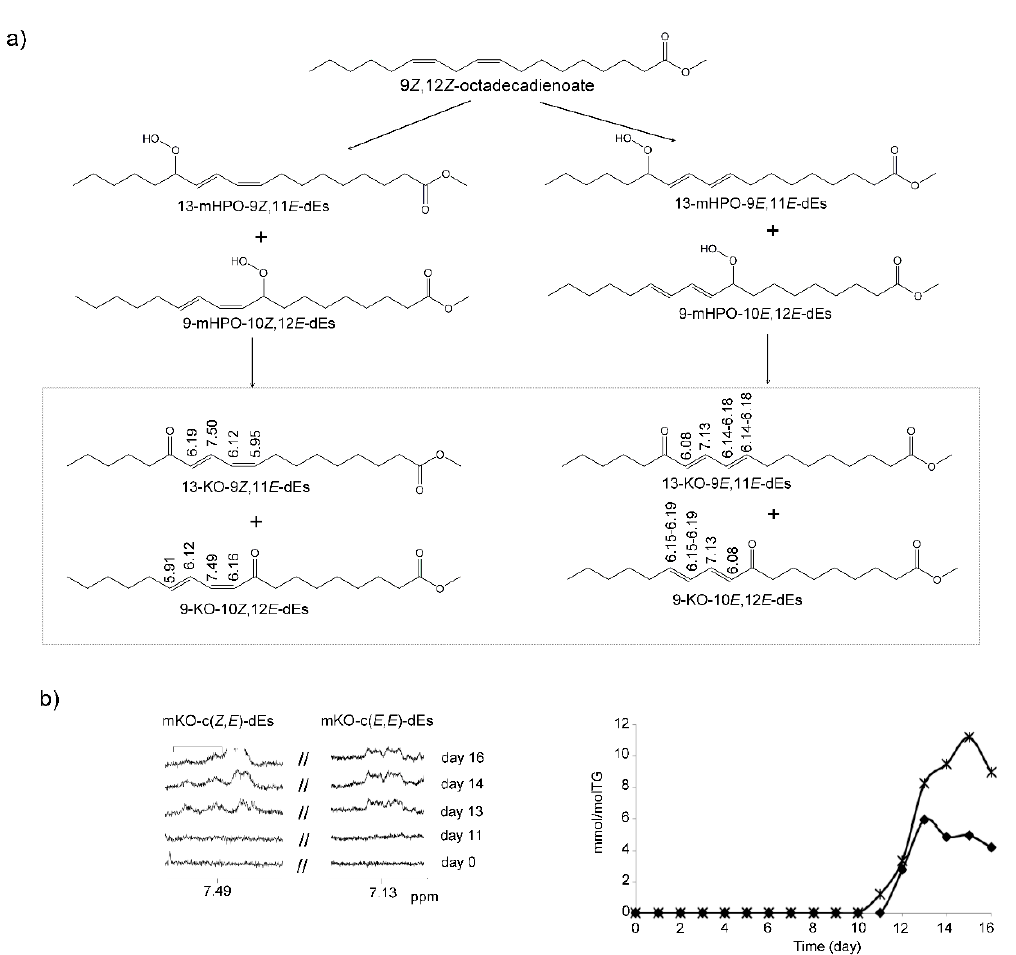
Figure 8. ( a ) Pathways of monoketo-conjugated dienes (mKO-c-dEs) formation proposed by some authors under certain oxidation conditions [61,70] together with some chemical shifts (ppm) of the 1 H NMR signals of some of their hydrogen atoms. ( b ) Enlargements of some spectral regions where changes occur throughout the accelerated storage process and their evolution with time, together with the graphical representation of the evolution of the concentration, expressed as mmol/mol TG versus time given in days of mKO-c( Z,E )-dEs ( ♦ ); mKO-c( E,E )-dEs (*).